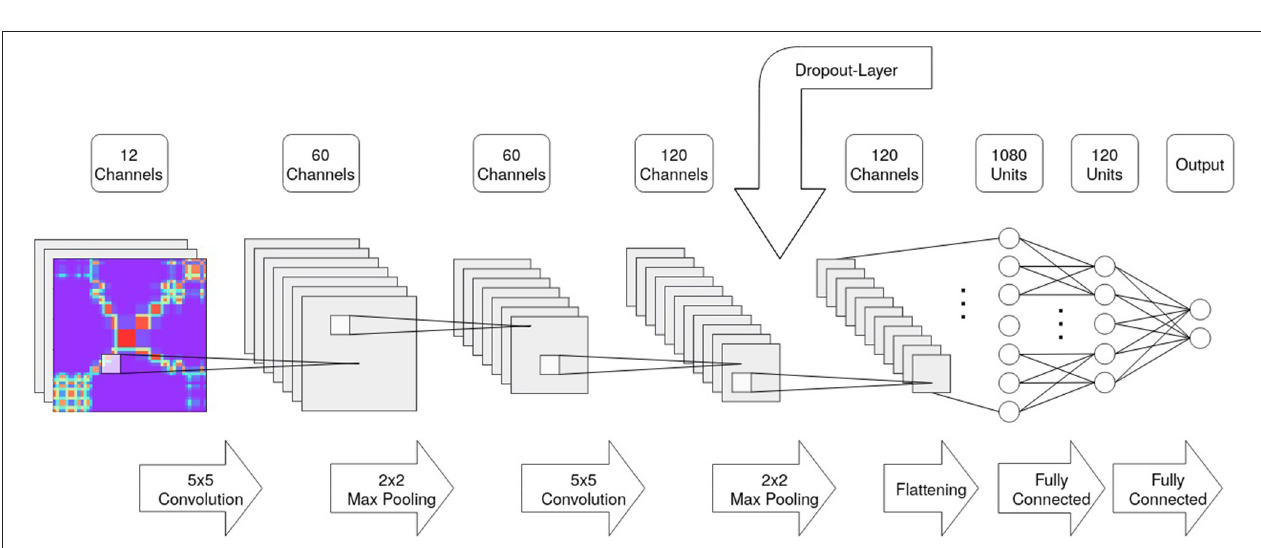
FIGURE 6 | (A) Exemplary feature matrix (3 × 4) made up of 12 images generated during the ITS approach as described in section 2.2.2. An external numeric trial from the switch-task is represented. Each row represents one of the transformation algorithms with one image for each eye/axis combination. (B) Heatmap of the gaze points representing the same trial.